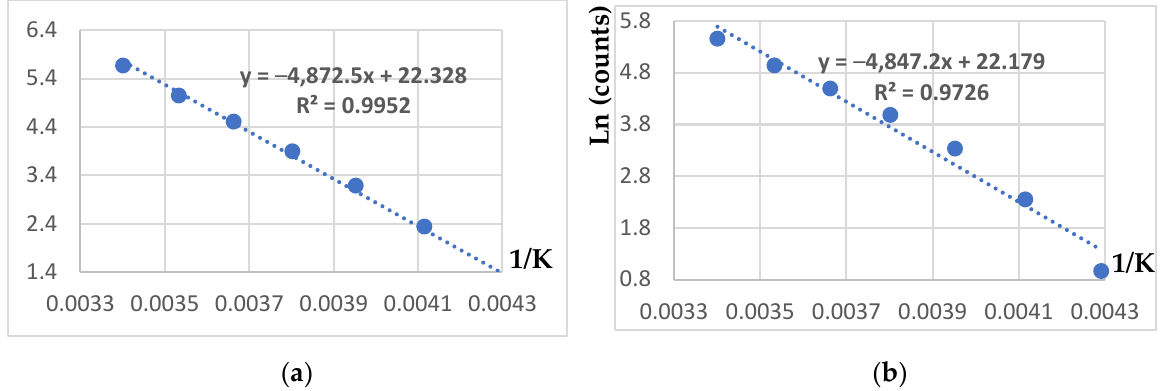
Figure 9. Dependence of the natural logarithm of the background current of the sensor with the corresponding electrolyte sample on the reciprocal temperature, along the abscissa axis is 1/K, along the ordinate axis, the value of Ln (counts), the count is proportional to the current value in µ A: ( a ) For the electrolyte sample #6 Water/LiI/PC, J 2 = 0.05 mol/liter; ( b ) For the electrolyte sample #7 Water/KI/PC, J 2 = 0.05 mol/liter.